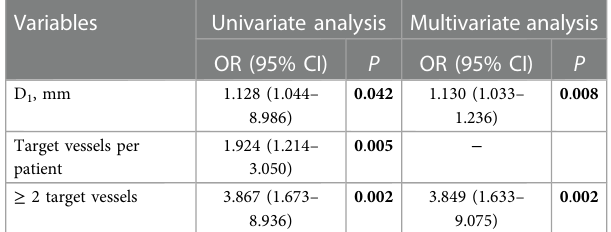
TABLE 2 Univariate and multivariate analysis of risk factors for TV-related endoleaks in 198 patients who had previously undergone fb-arch